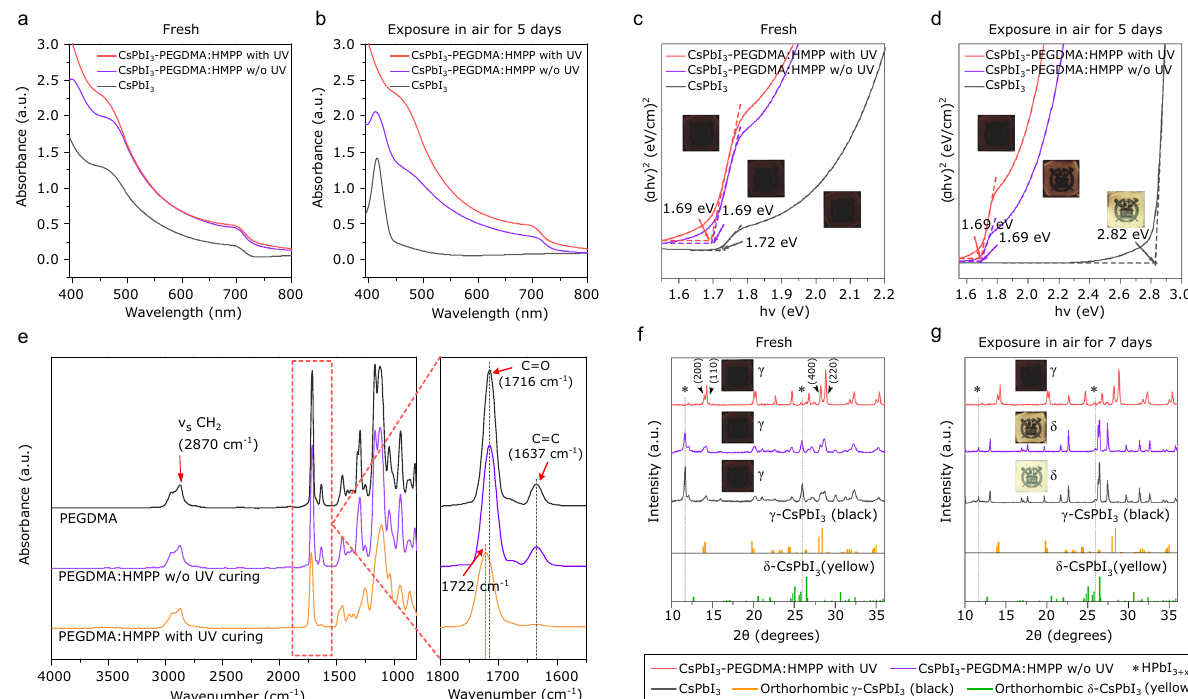
Fig. 1 Feasibility of long-term stable perovskite by UV-curable polymer network. a , b The UV – vis spectrum of the reference CsPbI 3 , and CsPbI 3 with or without UV-curing after the addition of PEGDMA, at the fresh state ( a ), and after 5 days left in the ambient conditions ( b ). c , d Tauc ’ s plot derived from the UV – vis spectroscopy analysis data of the fresh state ( c ), and after 5 days left in the ambient conditions ( d ). Inset: photographic images of the reference CsPbI 3 , and CsPbI 3 with or without UV-curing after the addition of PEGDMA. e ATR-FTIR spectroscopy analysis to investigate qualitatively for the conversion of C = C double bonds in the methacrylate group of PEGDMA whether UV irradiation. f , g XRD patterns of the reference CsPbI 3 , and CsPbI 3 with or without UV-curing after the addition of PEGDMA, at the fresh state ( f ), and after 7 days left in the ambient conditions ( g ). Asterisk (*): HPbI 3 + x 20 .